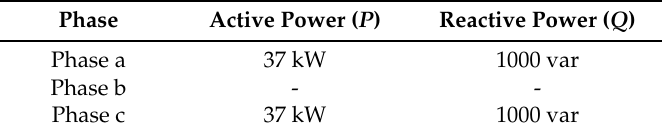
Table 2. Parameters of the hypothetical unbalanced load.